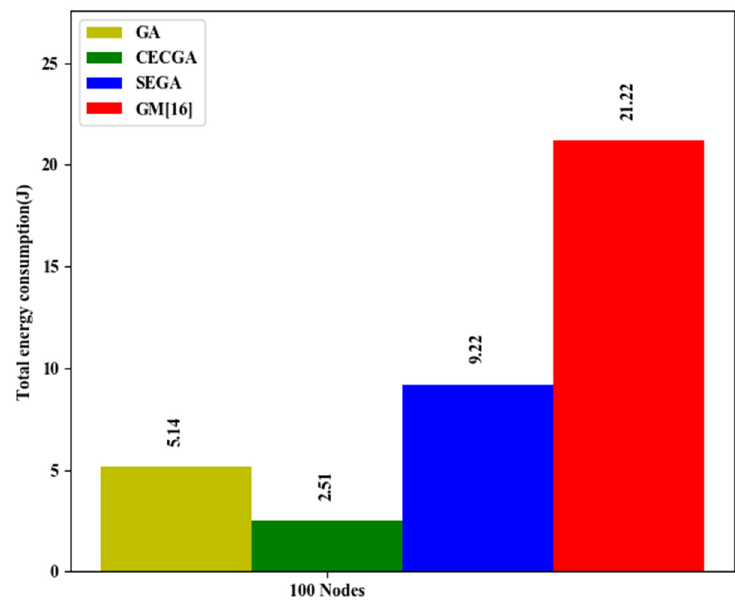
Figure 9. Total energy consumption (Different algorithms).